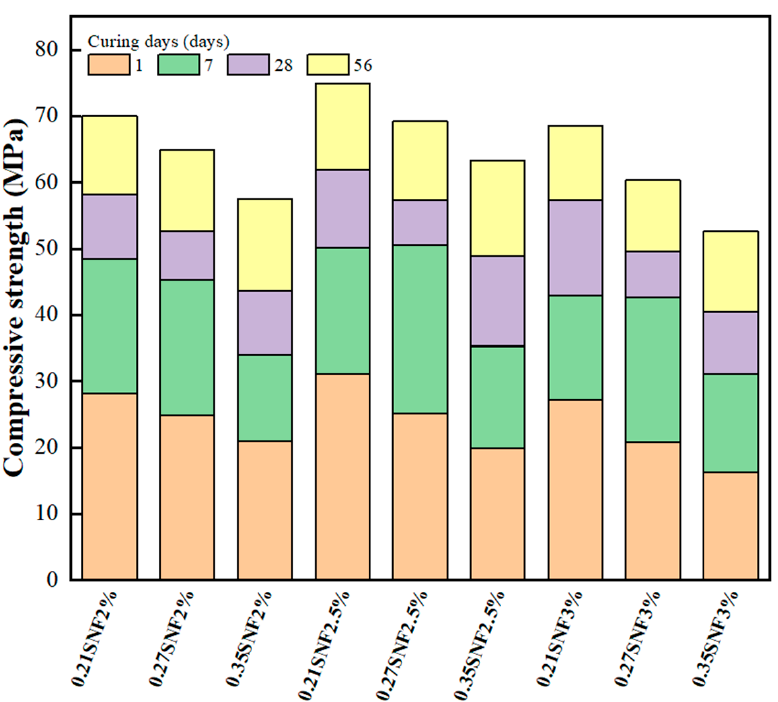
Figure 8. Compressive strength of green and ecofriendly grouting material with SNF.